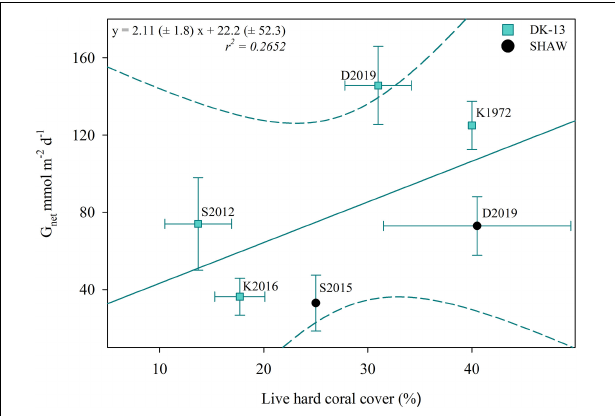
FIGURE 7 | Estimated percent live coral cover versus G net at DK-13 ( ± SE). In this case, the regression line does not correspond with a significant correlation ( p > 0.05). Dotted lines represent a 95% confidence interval. As in Figure 6 , K1972 refers to Kinsey (1972); S2012 refers to Silverman et al. (2012); K2016 refers to Kwiatkowski et al. (2016); S2015 refers to Shaw et al. (2015), and D2019 refers to this